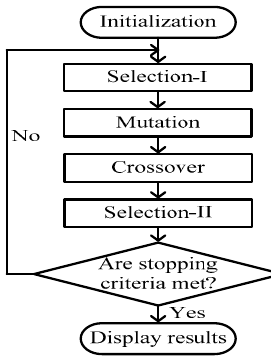
Figure 2. General flowchart of BSA.